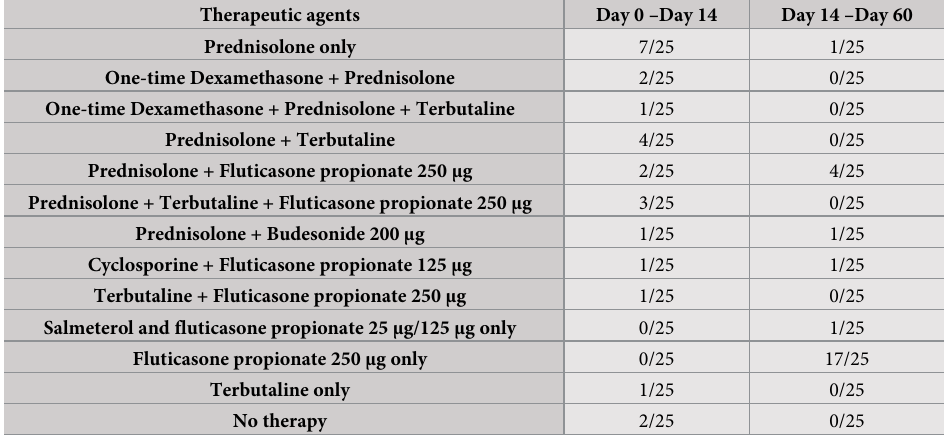
Table 2. Individual therapy in cats with FLAD between study time